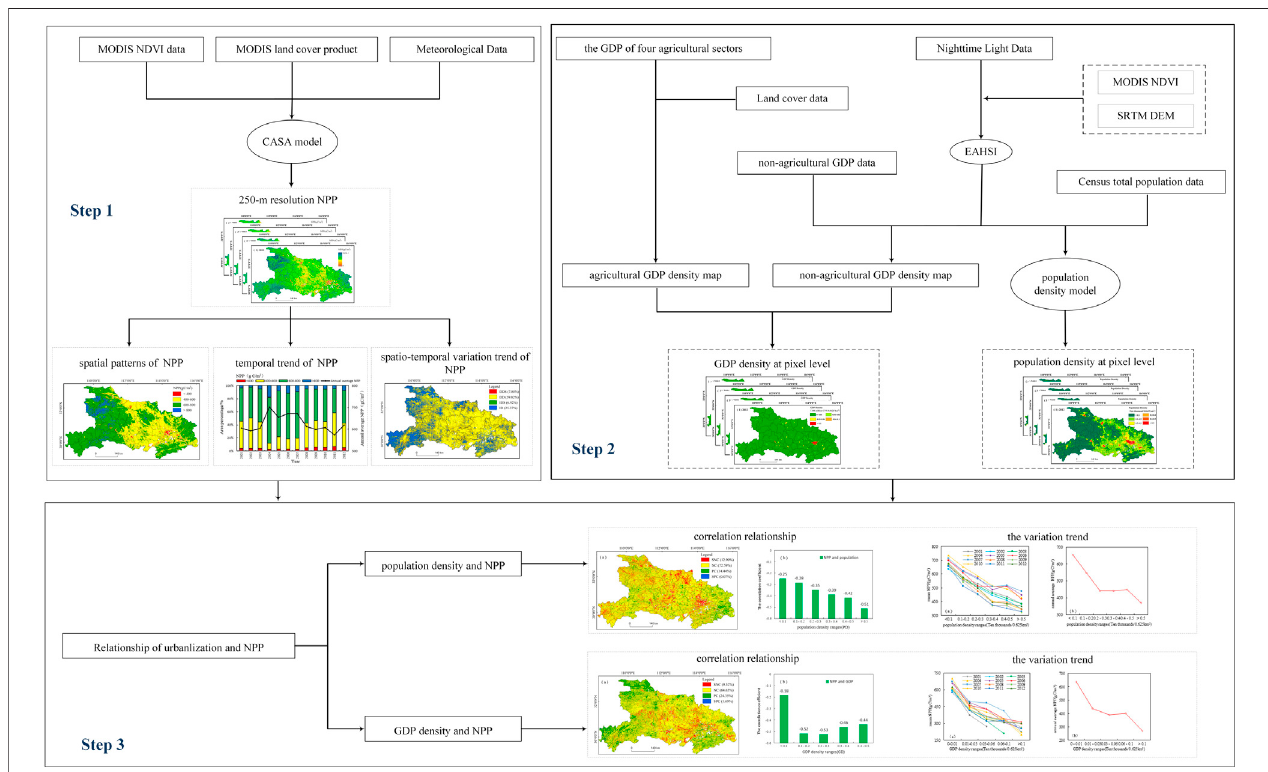
FIGURE 2 | Methodological framework of this study.